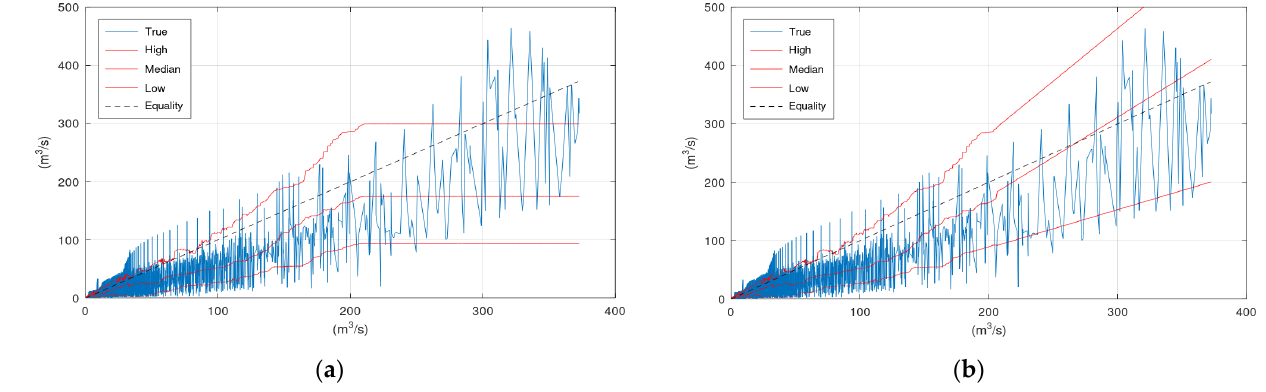
Figure A6. Scatter plot of the Sieve River case study: ( a ) KNN applied to the trimmed training data set; ( b ) KNN with linear extrapolation applied to the trimmed training data set.